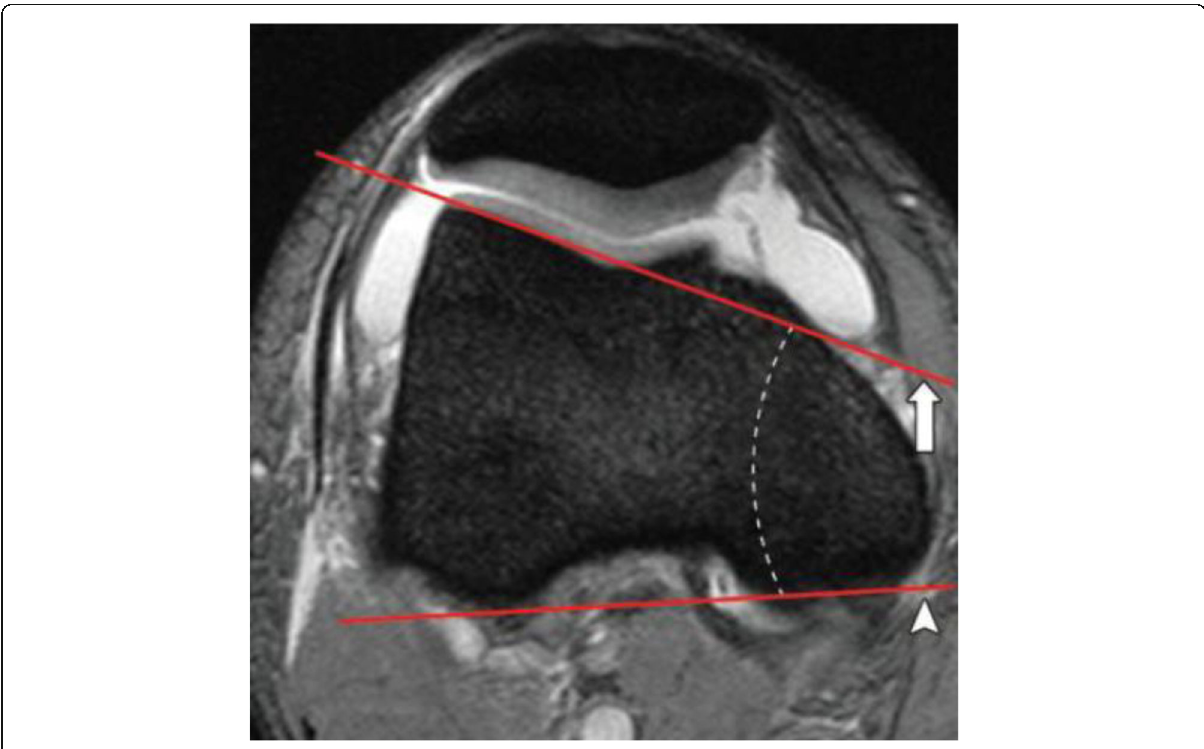
Fig. 2 Axial fat-saturated T2-weighted MR image for the assessment of the lateral trochlear inclination angle. The first line (arrow) was drawn tangential to the subchondral bone of the lateral trochlear facet, and a second line (arrowhead) was drawn tangential to the posterior aspect of the femoral condyles. The angle between the two lines was defined as the inclination angle (white dashed line). An inclination angle < 11° was considered as an indicator of trochlear dysplasia